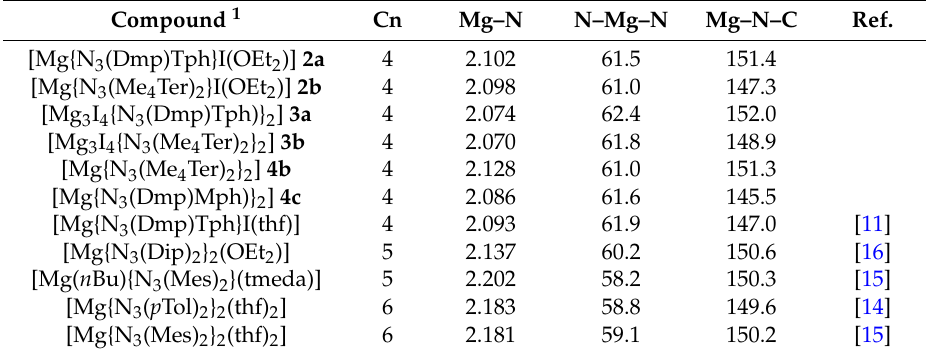
Table 2. Important structural parameters (av. values (Å, ◦ )) in magnesium triazenides. Compound 1 Cn Mg–N